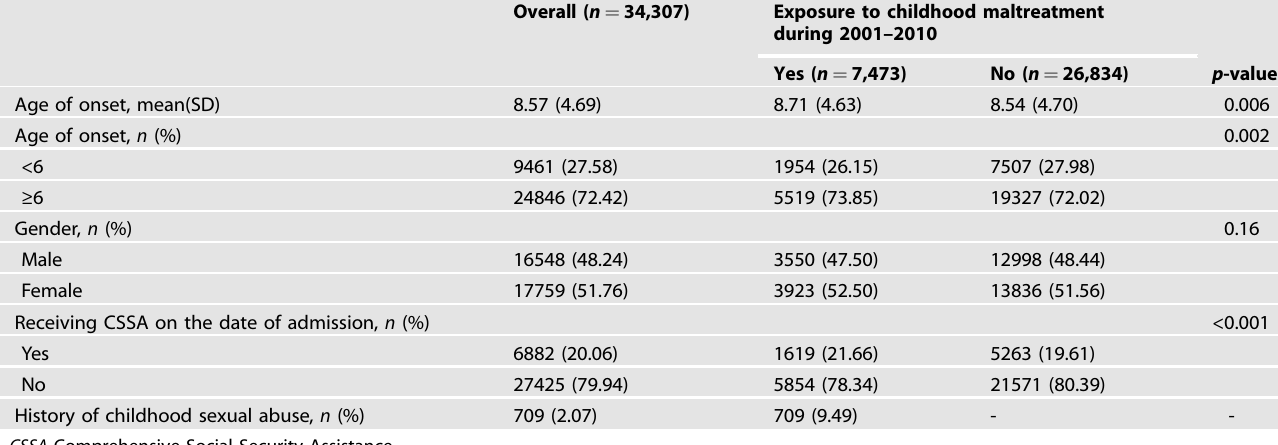
Table 1. Subject characteristics.